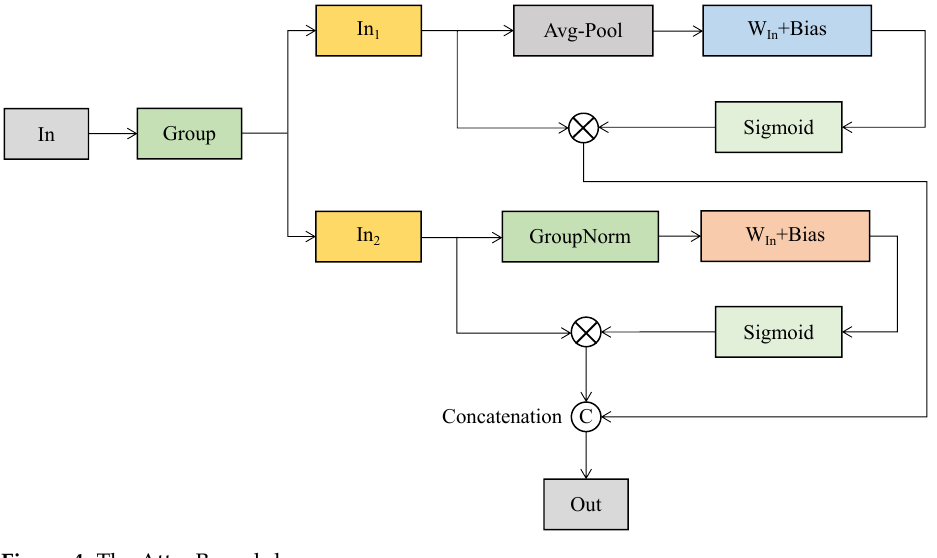
Figure 4. The AttenB